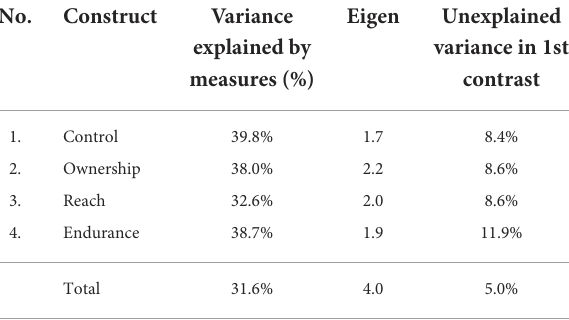
TABLE 6 Unidimensionality of AQ construct